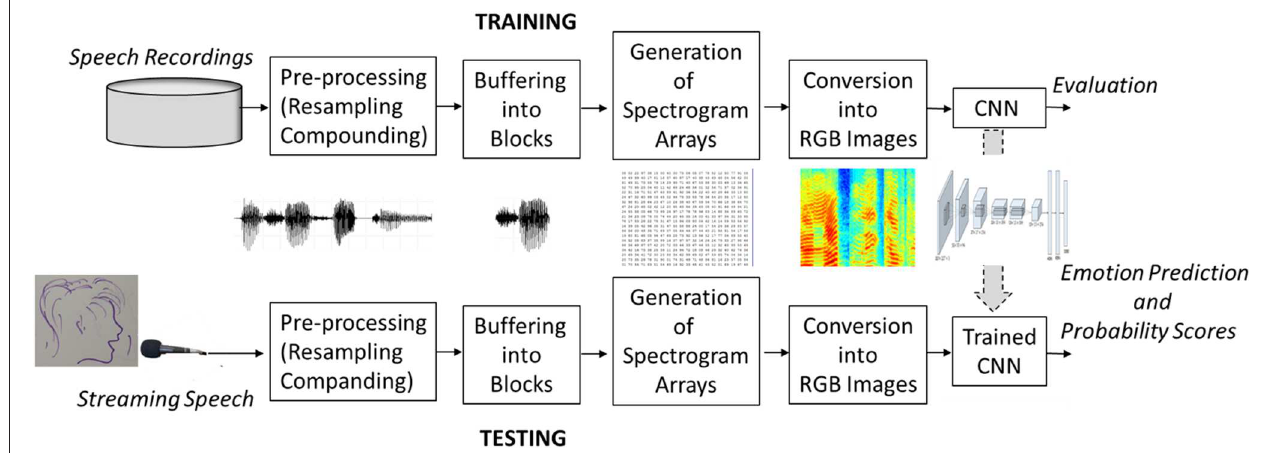
FIGURE 1 | An overview of the real-time SER